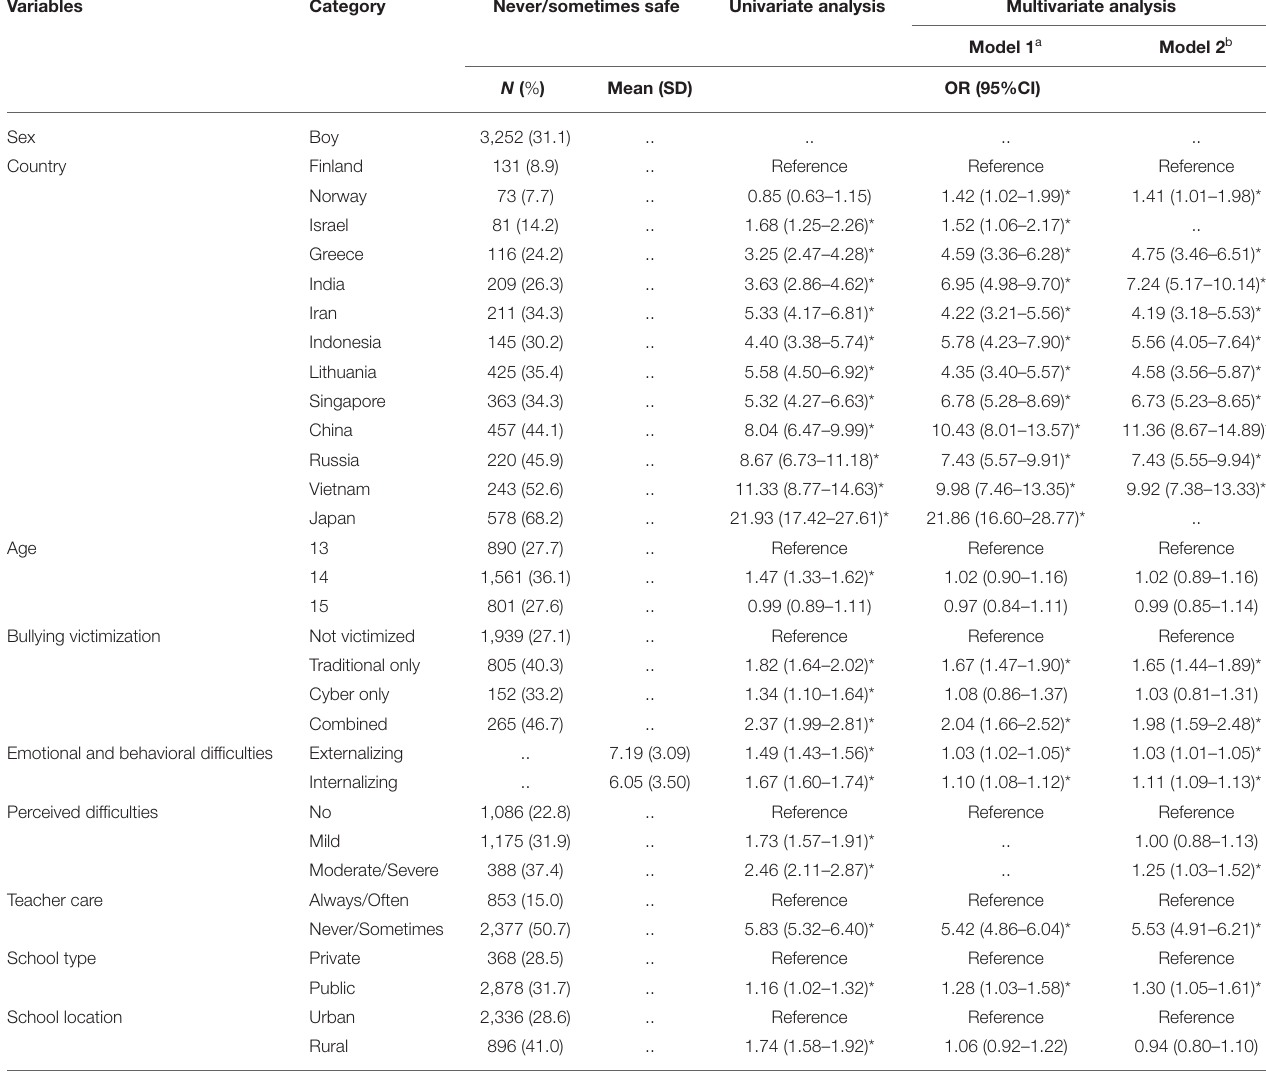
TABLE 4 | Univariate and multivariate analyses of the explanatory variables associated with feeling unsafe at school among boys.